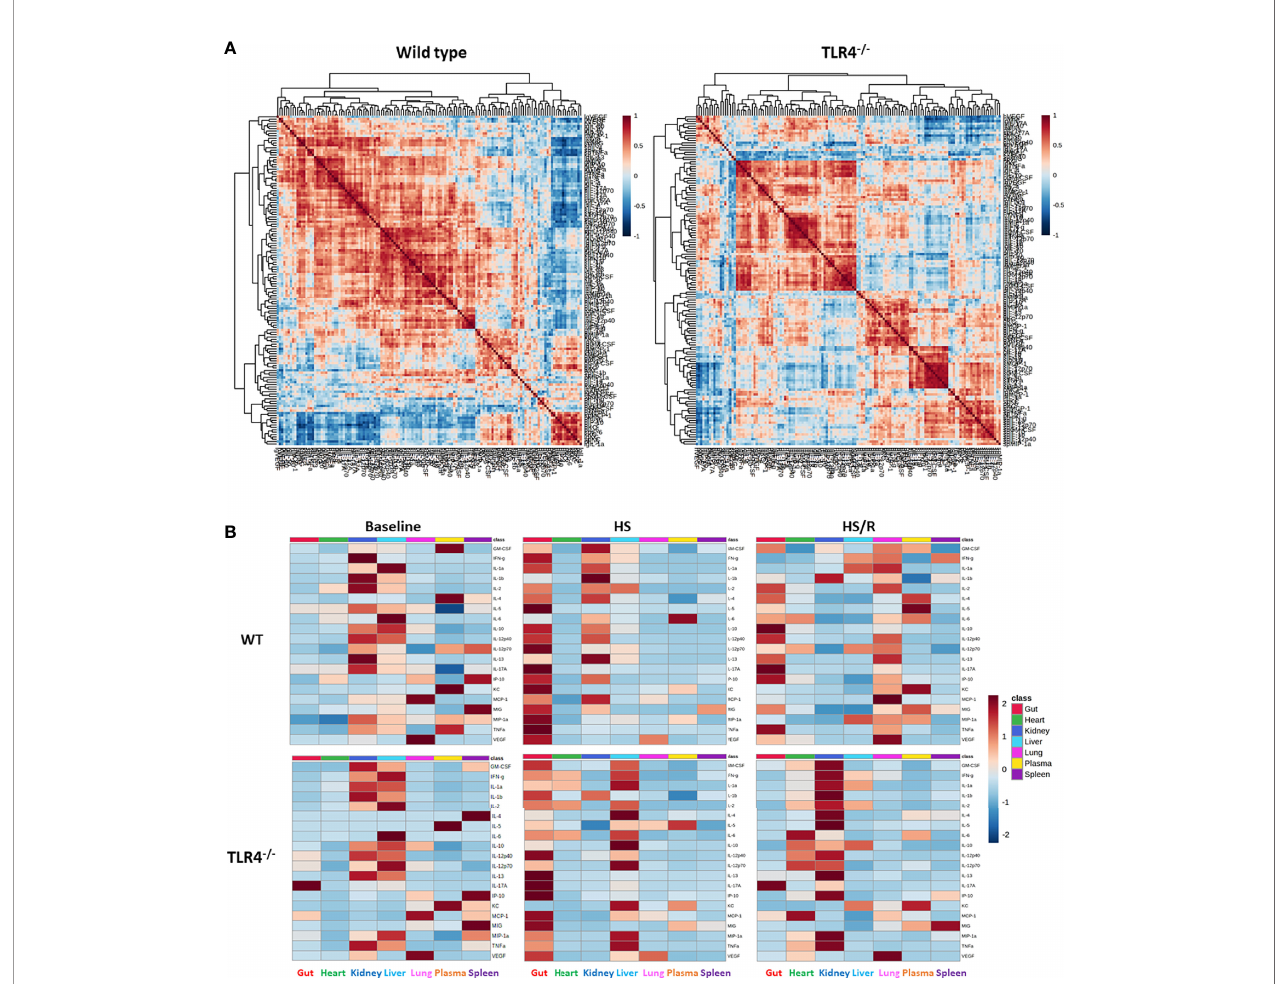
FIGURE 1 | Differential in fl ammatory correlation patterns in WT vs. TLR4 -/- mice. (A) Heatmaps show Spearman Rank Correlation patterns using all experimental data (Ctrl + HS + HS/R) in wild type vs. TLR4 -/- mice as described in Materials and Methods . (B) Heatmaps show the average concentration values for each mediator in each experimental group (Ctrl-Baseline, HS, HS/R in wild type vs. TLR4 -/- mice as described in Materials and